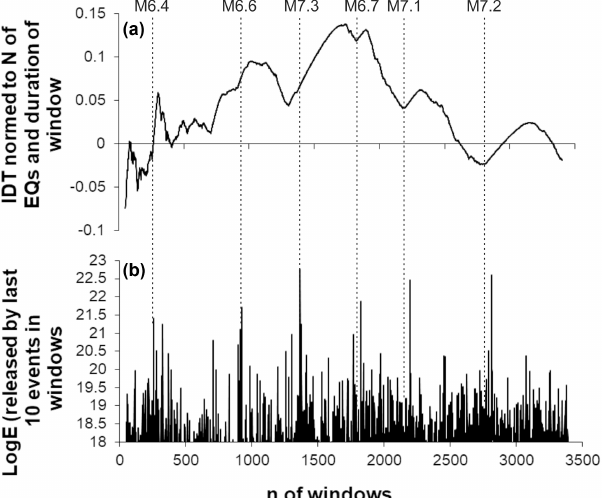
Figure 9. Calculated for the expanding (by consecutive 10 data) windows, integral deviation times (IDTs) (a) and the increments of seismic energies released by 10 last events in consecutive win- dows (b) obtained from the southern California earthquake catalog (above threshold M = 2 . 6). By the grey lines we show where the IDT curve crosses the abscissa. Dashed lines show the occurrence of largest earthquakes in the catalog.